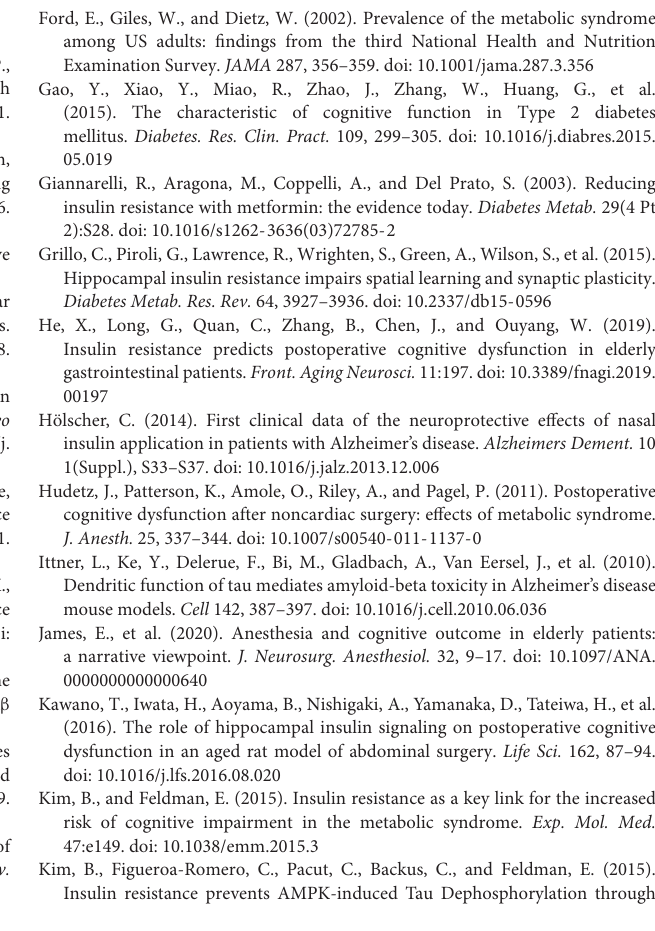
Supplementary Figure 1 | Metformin had no effects on the mRNA expression levels of hippocampal insulin-signaling pathway components Real-time quantitative RT-PCR showing the effects of isoflurane anesthesia, metformin, and anesthesia plus metformin pretreatment on the mRNA expression levels of IRS1, IRS2, Akt, and GSK3 β in hippocampus ( n = 3 mice per group). Supplementary Figure 2 | Metformin and blood glucose changes had no effects on the cued fear memory. (A) Freezing time to cue by adult WT mice receiving vehicle (Con), anesthesia (Anes), metformin (Met, 50 mg/kg), or metformin before anesthesia (Met + Anes) ( n = 7–8). (B) Freezing time to cue by T2DM mice receiving vehicle (DM), anesthesia (DM + Anes), metformin (DM + Met, 50 mg/kg), or metformin before anesthesia (DM + Met + Anes) ( n = 7–8 mice per group). (C) Freezing time to cue by adult WT mice receiving vehicle (Anes), metformin (Met + Anes), or 25% glucose 0.1 ml plus metformin (Glu + Met + Anes) prior to isoflurane anesthesia ( n = 7–8). Data are expressed as mean ± SD and analyzed with one-way ANOVA test followed by Bonferroni multiple comparison